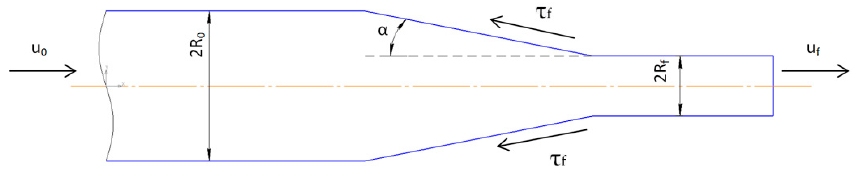
Figure 2. Wire drawing process.